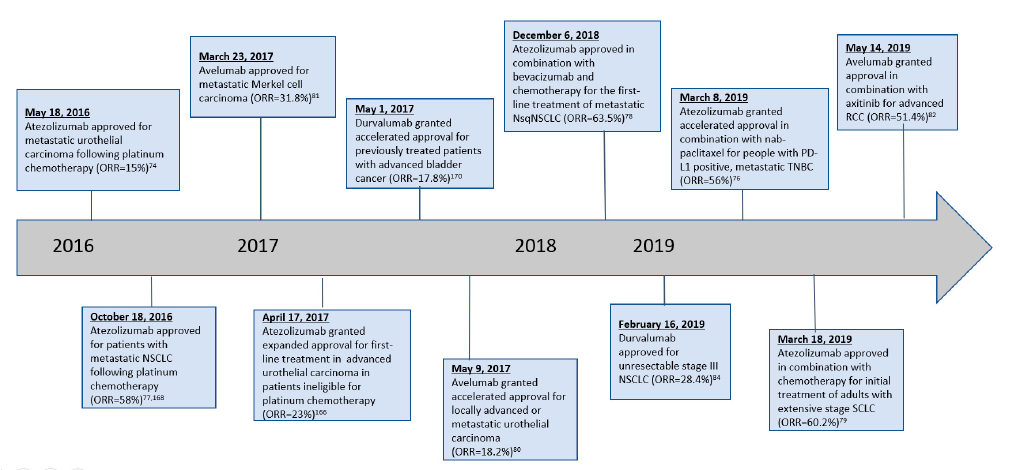
Figure 5. Timeline of PD-L1 inhibitor FDA approvals.